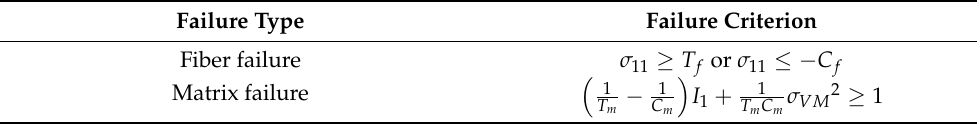
Table 10. The MMF-based criteria for the micro-scale failure determination.